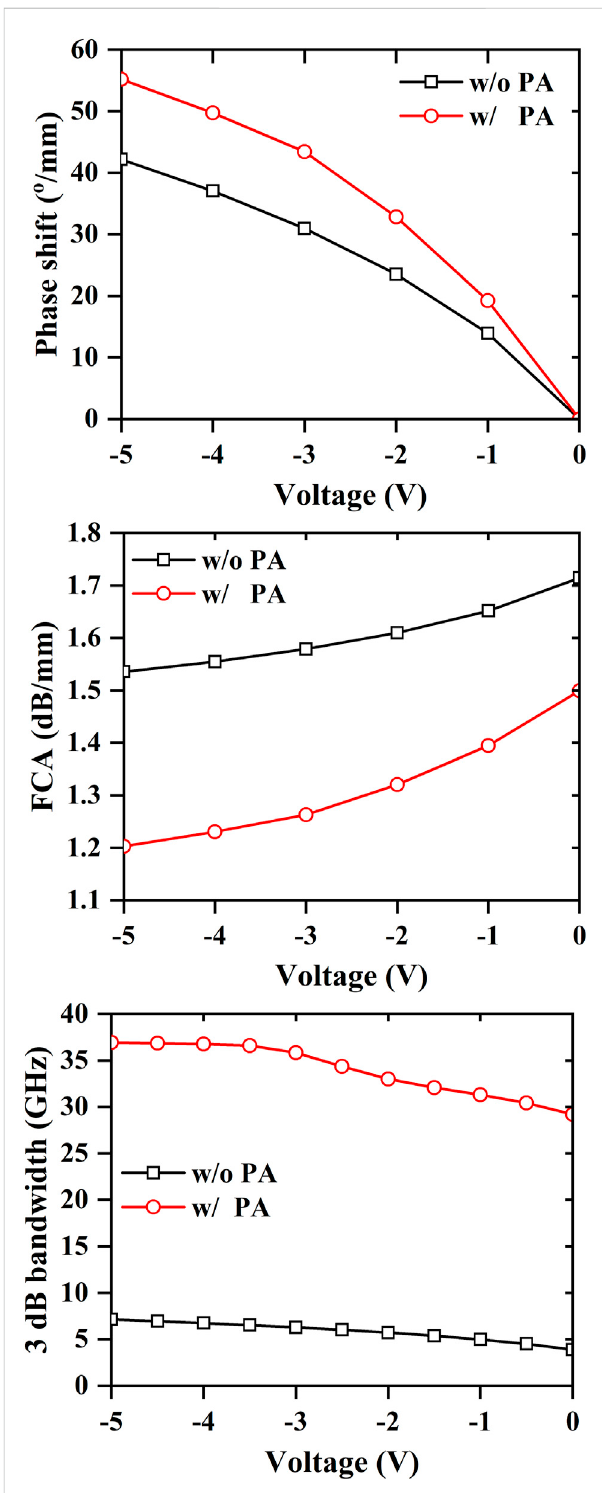
FIGURE 10 (A) Phase shift per unit length, (B) free-carrier absorption per unit length, and (C) 3-dB bandwidth for crystalline and pre-amorphized wafer (w/o PA: without pre-amorphization; w/PA: with pre-